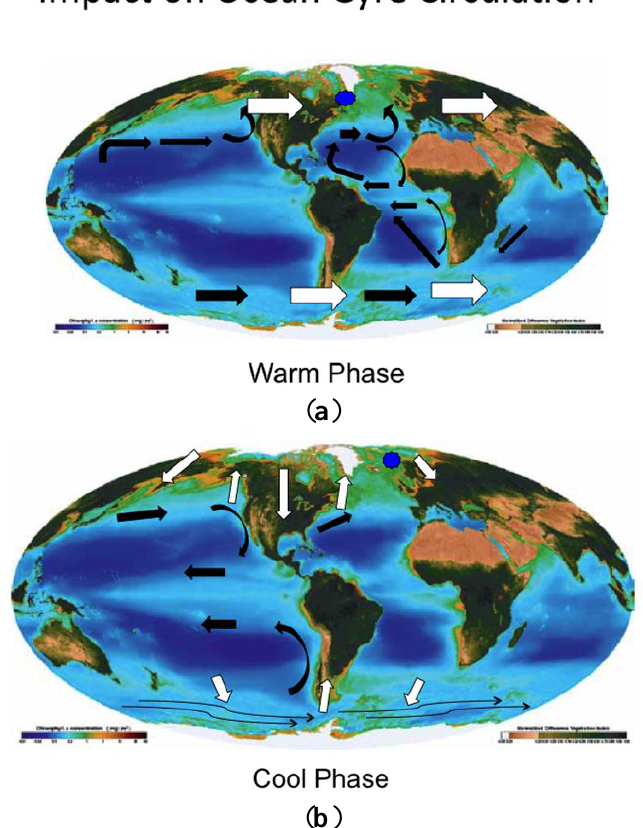
Figure 3. Global wind and gyre circulation changes hypothesized to be associated with multidecadal ( a ) warm and ( b ) cool phases of the North and South Hemispheres. White arrows indicate regions of enhanced wind and black arrows indicate areas of enhanced gyre circulation. The blue patches indicate the sinking waters in the North Atlantic. The